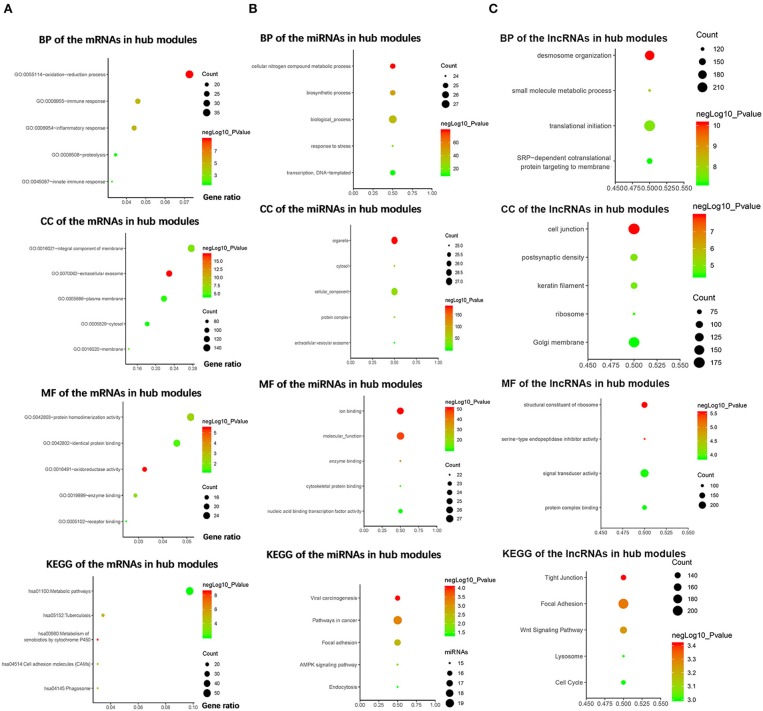
Bioinformatics analysis of the messenger RNAs (mRNAs) and the microRNAs (miRNAs) in hub modules. (A) Gene Ontology (GO) analysis and Kyoto Encyclopedia of Genes and Genomes (KEGG) pathway enrichment of the mRNAs in green and cyan modules. (B) GO analysis and KEGG pathway enrichment of the miRNAs in pink and purple modules. (C) GO analysis and KEGG pathway enrichment of the lncRNAs in the yellow and midnight blue modules.